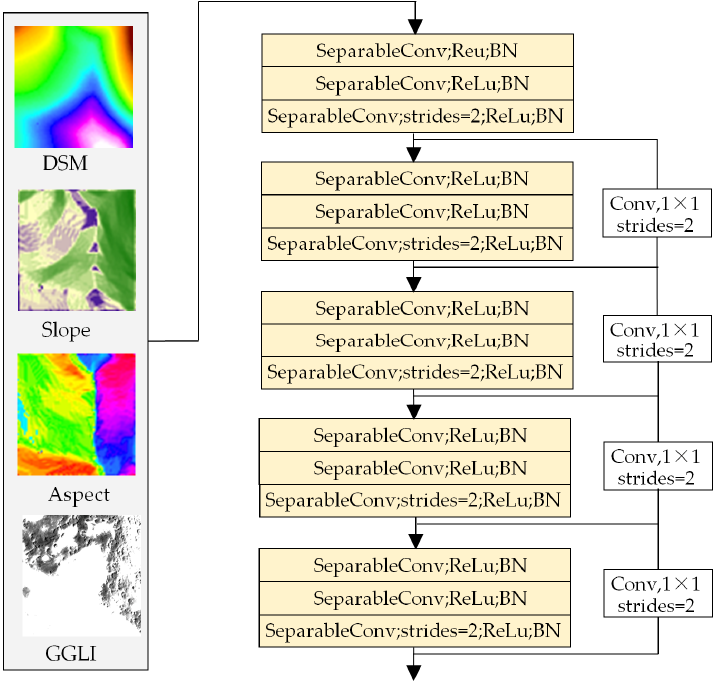
Figure 4. Architecture of topographic CNN. BN denotes the operation of batch normalization.